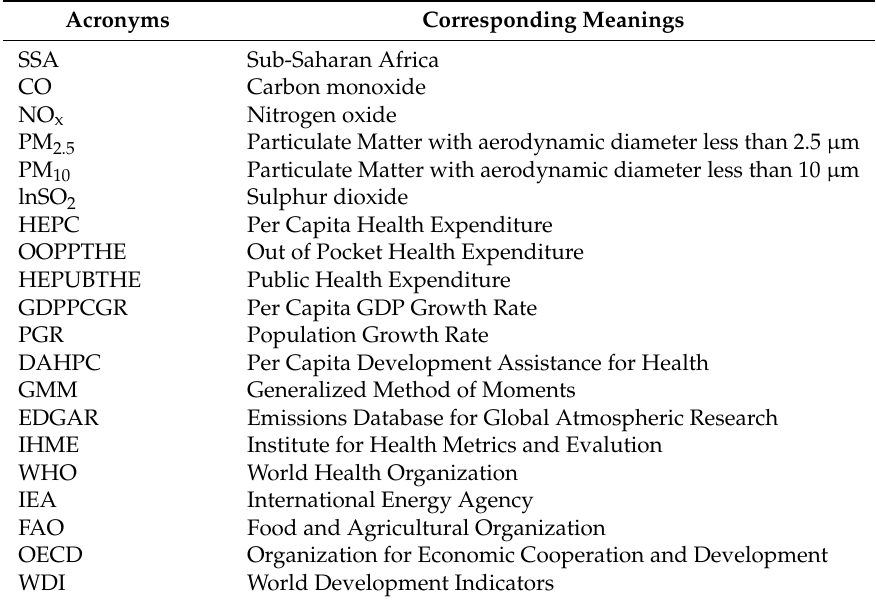
Table A2. List of key acronyms and their corresponding